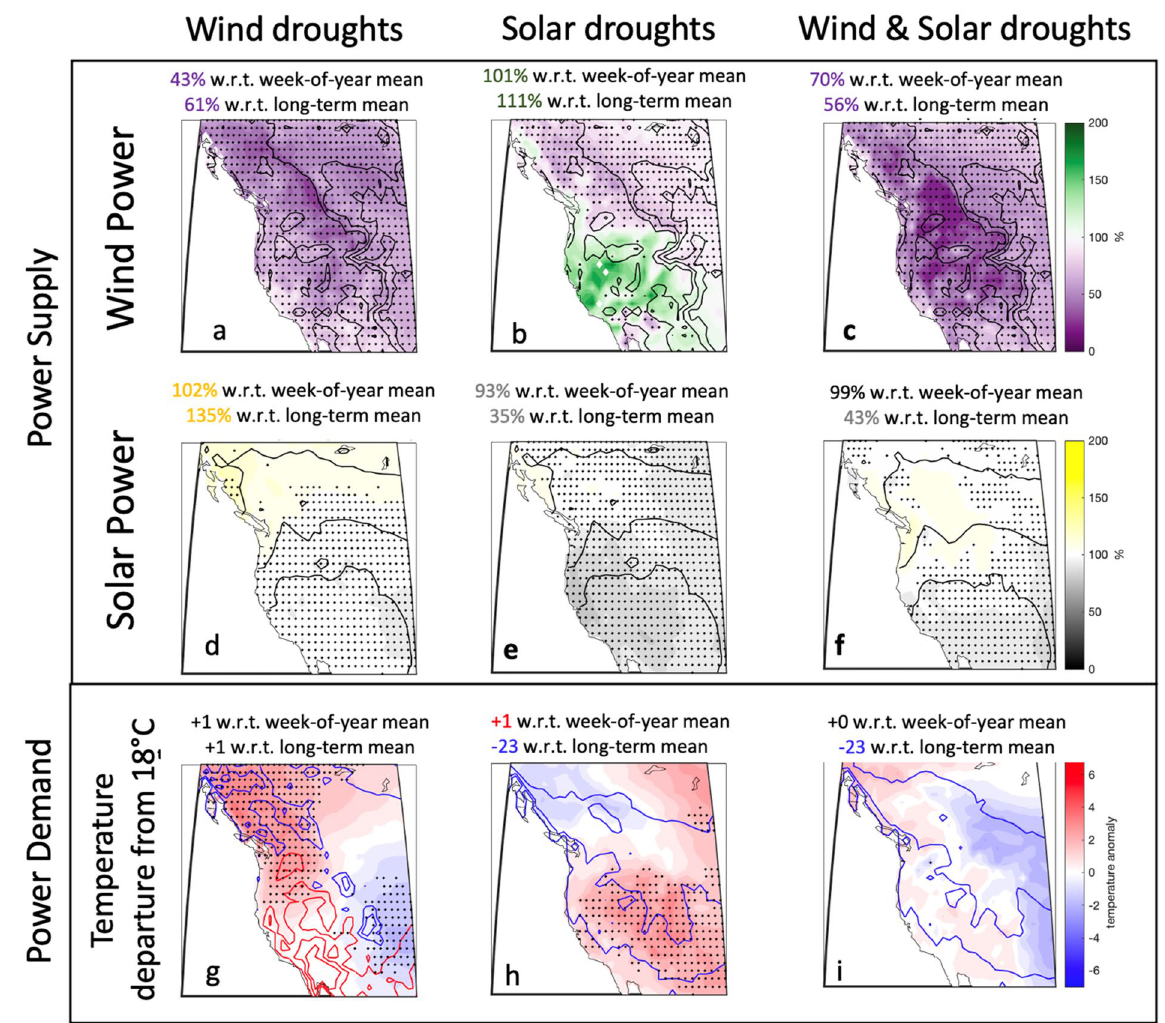
(annual) mean are displayed atop each panel. The contours in pan- els a–c show the same values as Fig. 1c and the contours in pan- els d-f show the same values as Fig. 1f which helps illustrate how the anomalies interact with the mean spatial distribution of the resources. The absolute deviation from 18 °C (65°F) are contoured in g-i with positive values contoured red and negative values con- toured blue. Figures S6–S9 show plots for each individual drought event. Figures S16 and S19 shows the sensitivity of this plot to defining droughts using either the 0.5th percentile (Fig. S16) or the 2nd percentile (Fig.